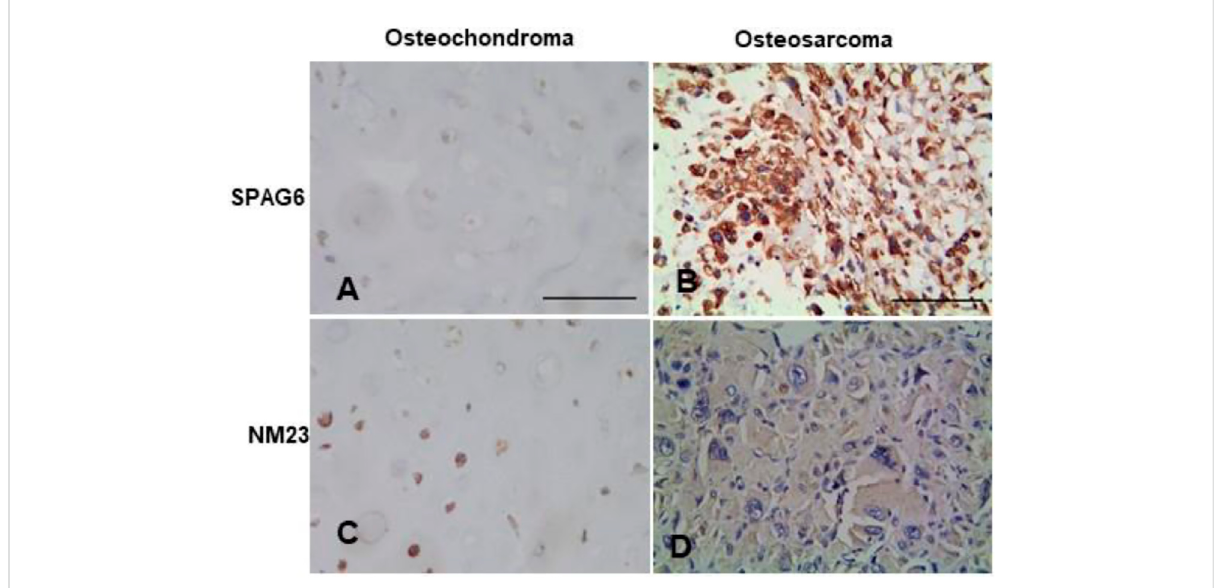
FIGURE 1 RepresentationmicrographsshowingSPAG6andNM23proteinsinosteochondromaandosteosarcomatissues(Elivision). (A,B) SPAG6staining is predominantly localized in the cytoplasm in the osteochondroma tissue and osteosarcoma tissue. (C,D) NM23 staining is predominantly localized in the cytoplasm in the osteochondroma tissue and osteosarcoma tissue. Scale bar = 50 μ m.